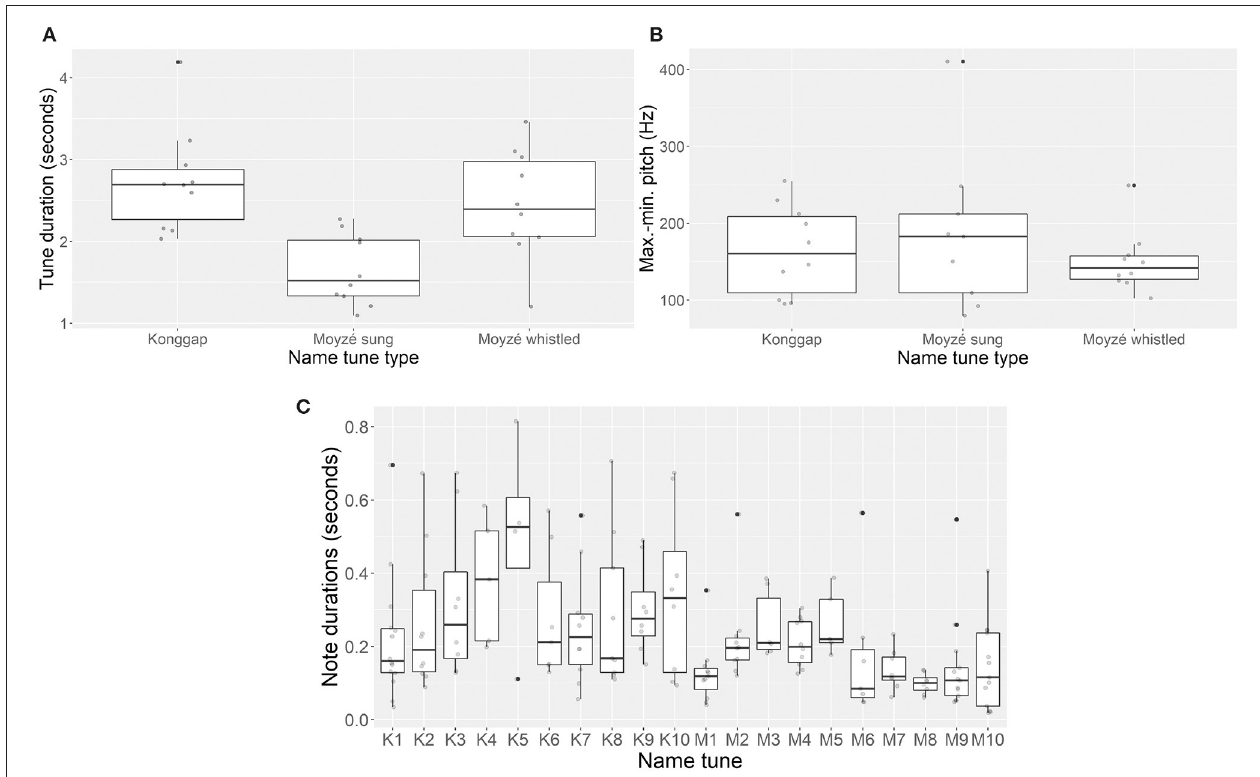
FIGURE 2 | Tune duration, pitch range, and average note duration for sampled konggap and moyzé ( K = konggap , M = moyzé